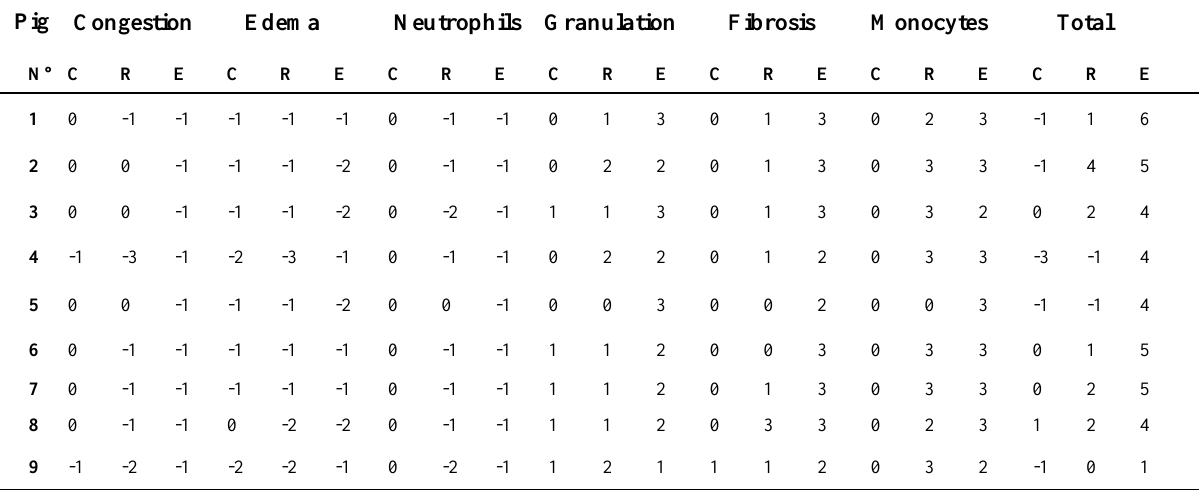
Table 5 – Percentage of collagen and smooth muscle in the studied areas. (mean ± standard deviation)